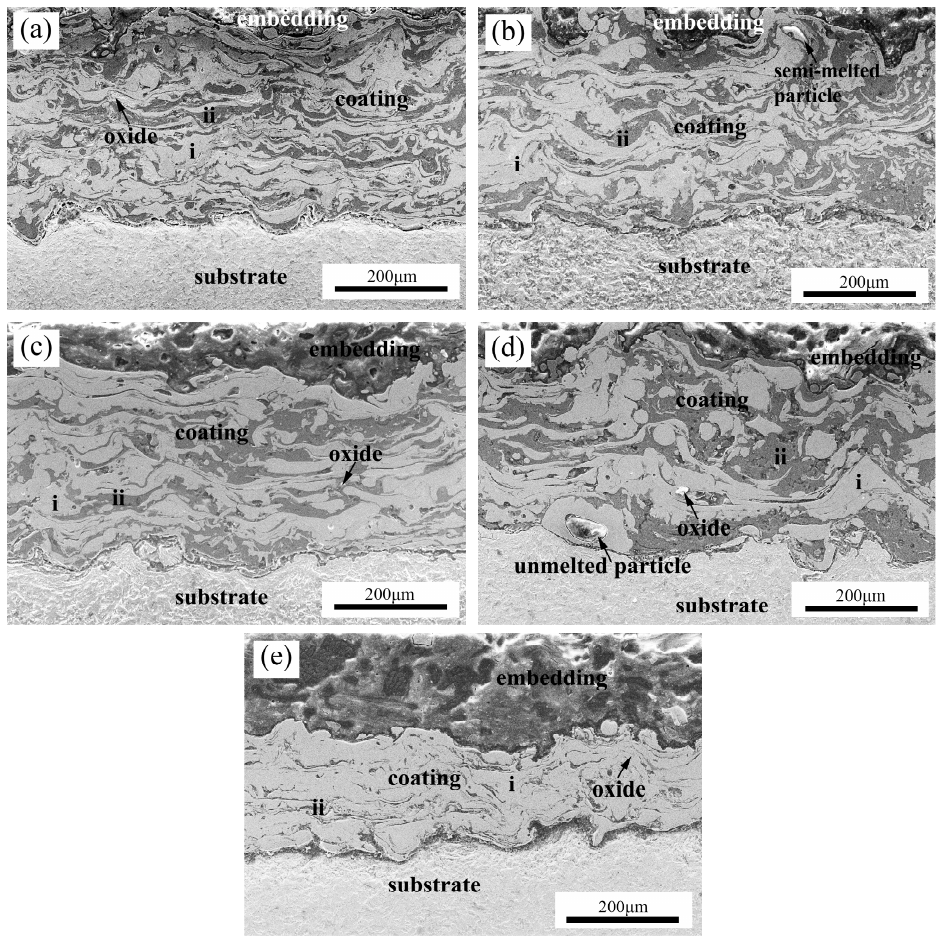
Figure 3. Cross-section images of the coatings ( a ) #A, ( b ) #B, ( c ) #C, ( d ) #D and ( e ) FeCrAl with (i)